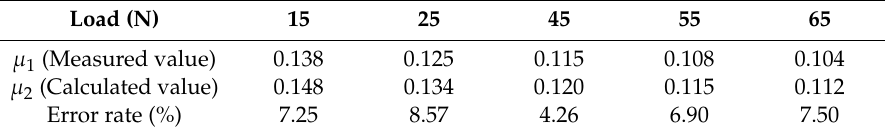
Table 4. Friction coe ffi cient measurement and function model prediction.